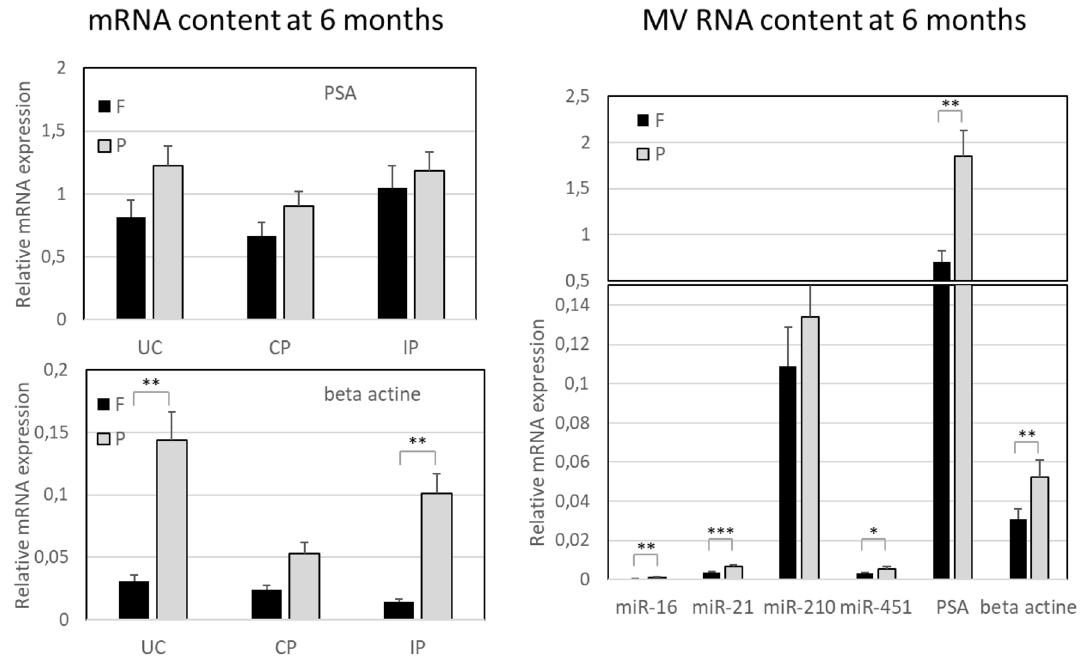
Figure 4. Quantification of EV RNA and MV RNA/miRNA content. Total RNA is extracted from MV pellets and from EVs purified from healthy donor-obtained urine samples (N = 3), stored either pre-served at room temperature (P) or frozen (F), using ultracentrifugation-based protocol (UC), chemical precipitation (CP) or immunoprecipitation with anti-CD9 coated beads (IP). RT-qPCR amplification of mRNAs prior described to be contained in urine EVs, namely β-actin and RNY RNA was done as de-scribed in Material and Methods. Both these mRNAs and miRNAs (miR-16, miR-21, miR-210 and miR.451) were analyzed also in MVs. Samples from three healthy donors, and 2 independently processed aliquots from each donor, are included in the assessment. One-way ANOVA and Bonferroni post-hoc test were used to determine statistical significance of observed differences * indicates p-value < 0.05, ** p-value < 0.01 and *** p-value <